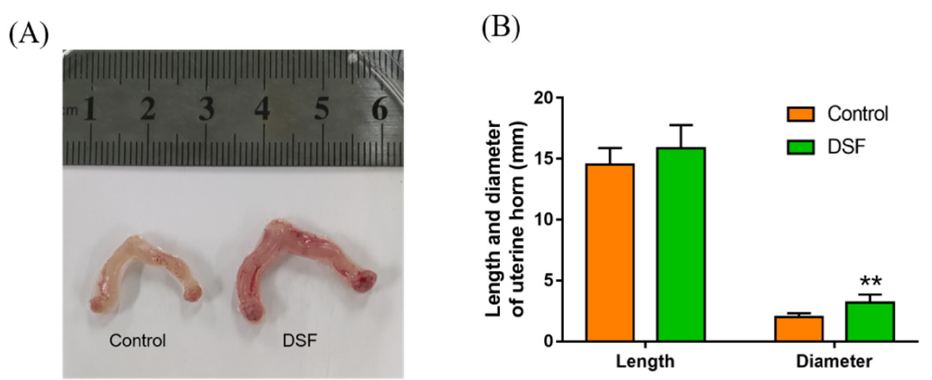
Figure 9. Effect of DSF on degree of vascularization and the length and diameter of the uterine horn in pregnant mice. ( A ) Representative images of uterine horn vascularization in the control and DSF groups; ( B ) the length and diameter of the uterine horn in the control and DSF groups. ** p < 0.01. Control group, n = 8; 50 mg/kg DSF group, n = 8.